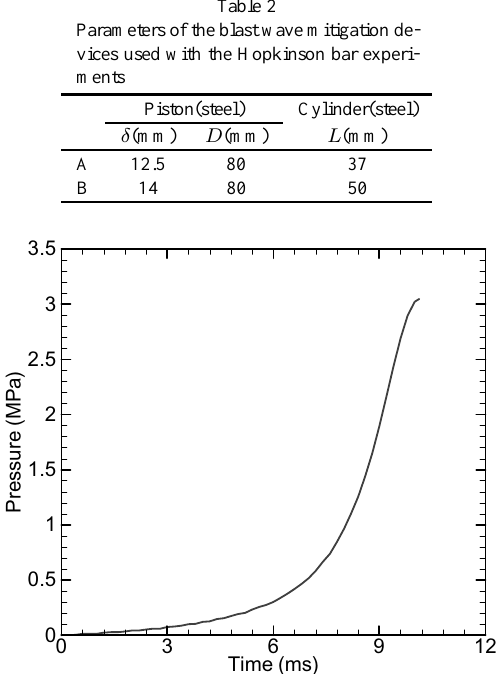
Fig. 10. Predicted pressure on the base of the blast wave mitigation